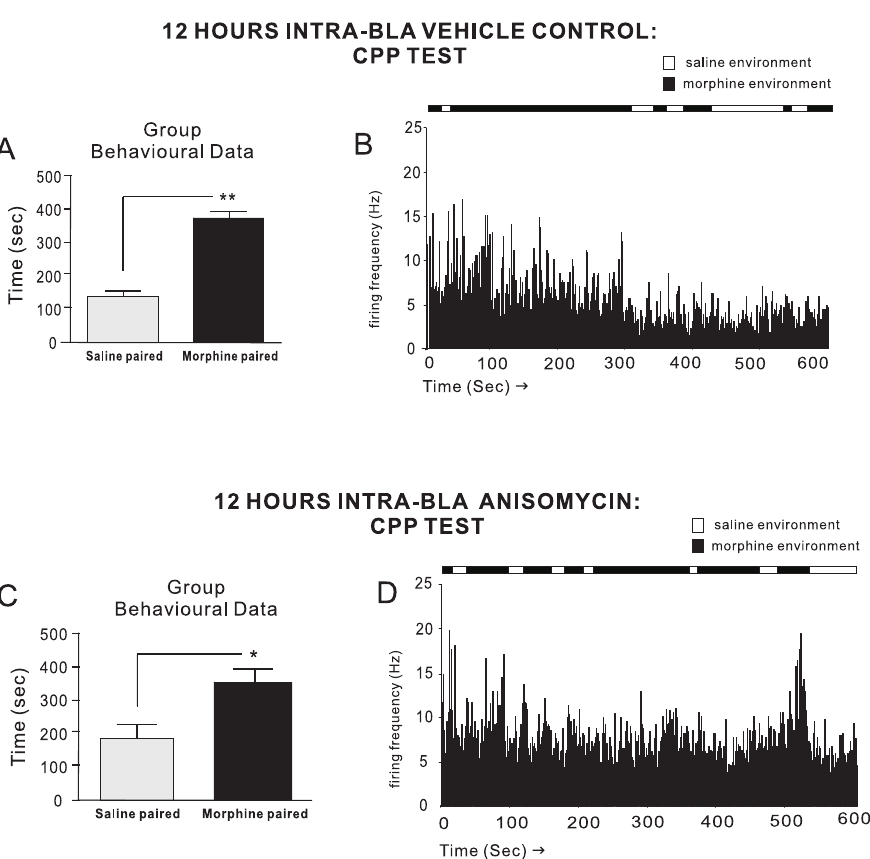
Figure 8. Effects of later (12 hr) intra-BLA protein synthesis inhibition on behavioral and mPFC neuronal opiate memory consolidation. Group CPP data showing that intra-BLA vehicle A , or anisomycin administration ( C ) at 12 hrs post-conditioning does not block subsequent behavioral recall of consolidated opiate reward memory. In addition, mPFC neuronal populations show robust, associative firing rate increases in response to morphine environment exposures during real-time CPP test recordings (panels B , D ; raster samples taken from single rats showing mPFC neuronal firing recorded in real-time across saline or morphine-environmental exposure).